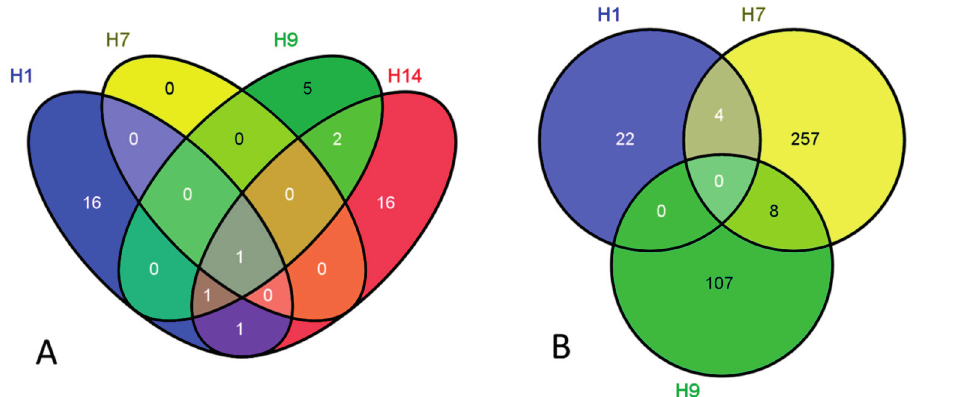
Figure 1. Venn diagrams of differentially expressed genes following low-dose ionizing radiation (LDIR) exposures: ( A ) upregulated genes and ( B ) repressed